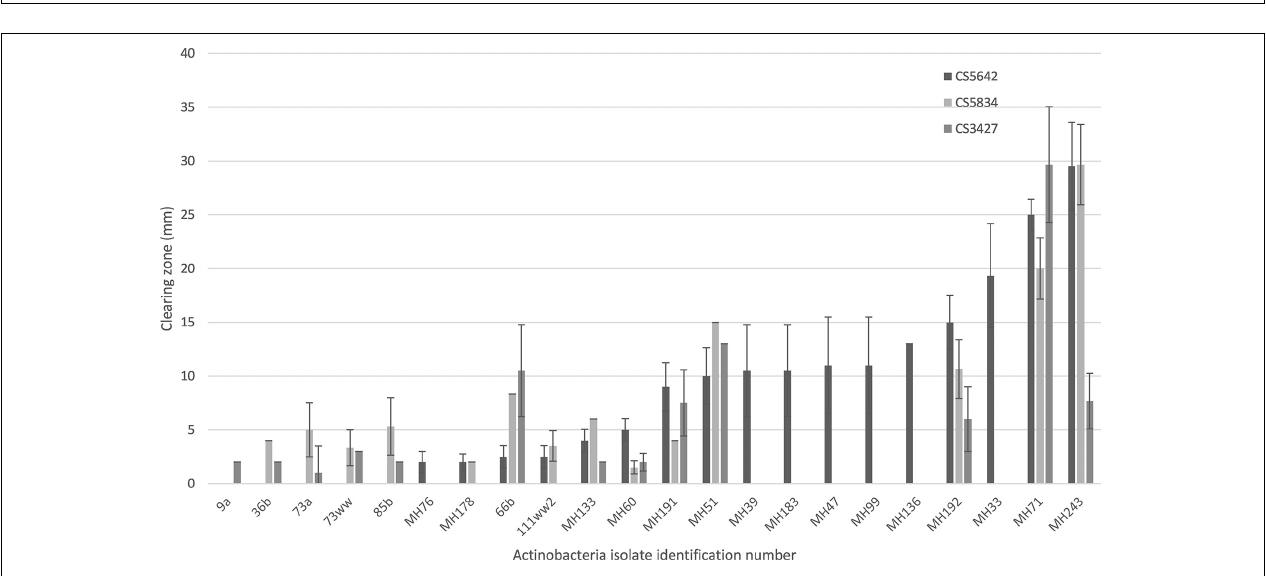
FIGURE 3 | MH243 (black lawn at top of left hand plate) inhibited growth of F. pseudograminearum CS5642 (inoculated via plug at bottom of both plates) compared with control plate containing F. pseudograminearum CS5642 alone (on right).